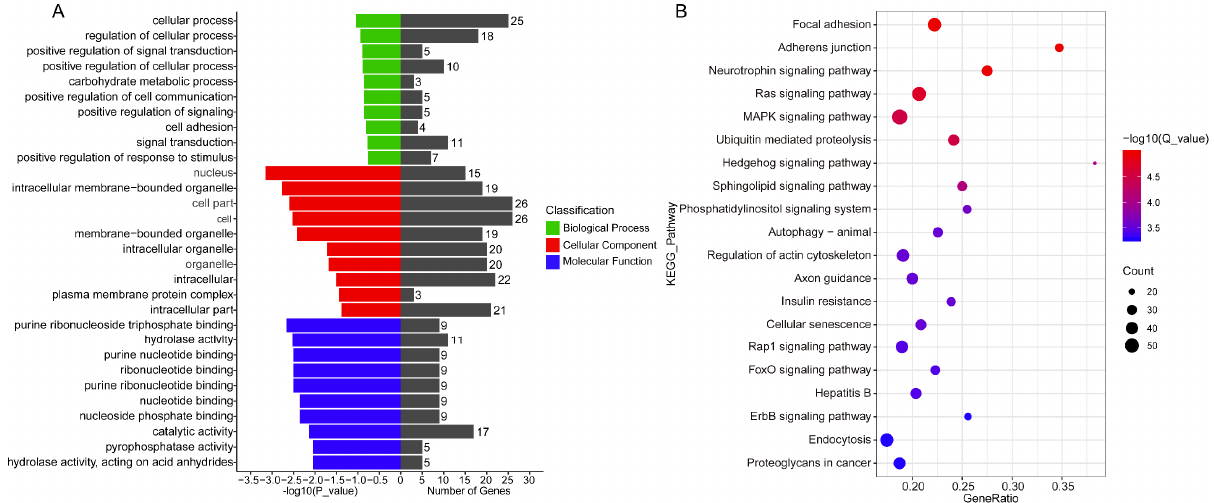
Figure 3. The biological function analysis of the host gene of circRNAs. ( A ) The GO enrichment analysis of host genes of circRNAs. The right x -axis indicates the number of gene in a category, and the left y -axis indicates the specific category of GO. Green: biological process, red: cellular component and blue: molecular function. ( B ) Scatter plot shows the KEGG pathway enrichment analysis of the host gene of circRNAs.